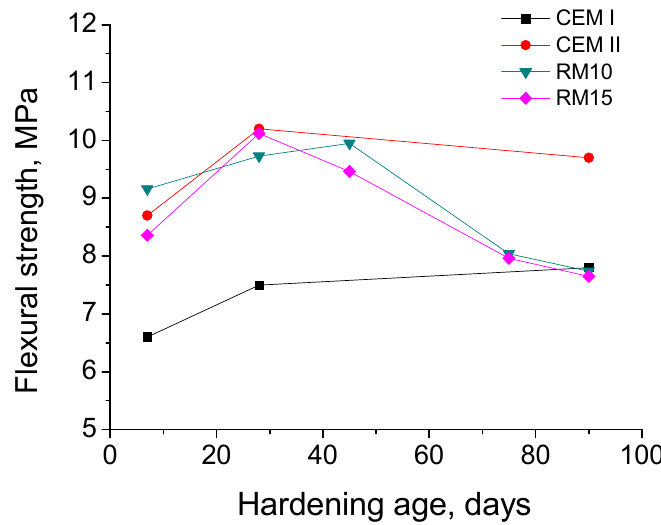
Figure 12. Results of flexural strength for CEM I, CEM II, RM10 and RM15 mortars.